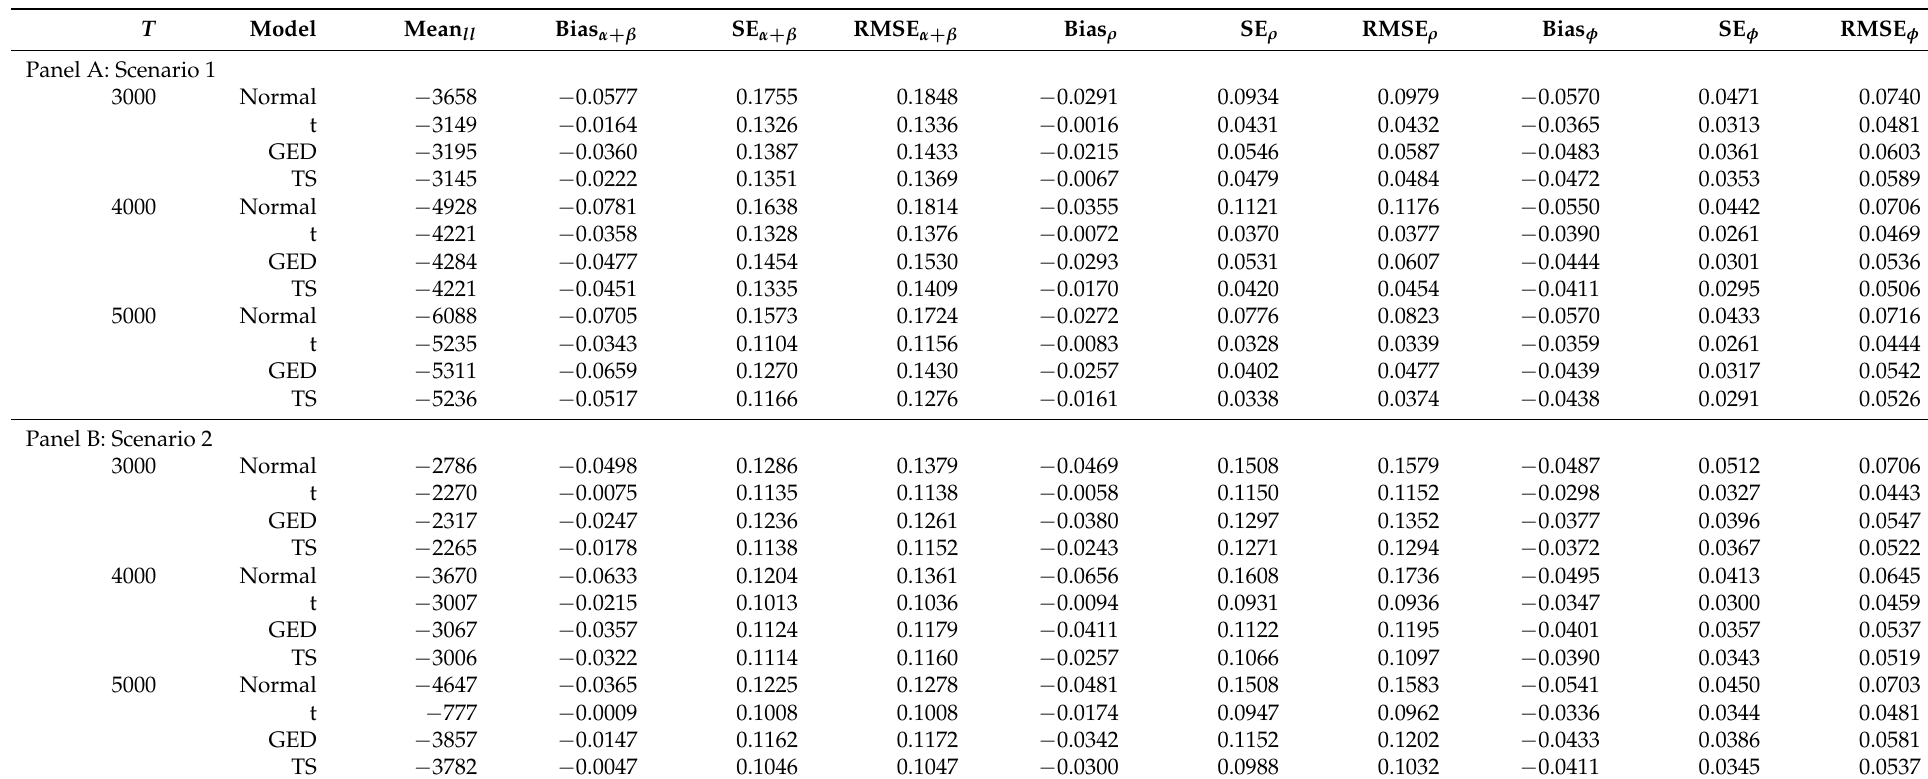
Table 1. Simulation results: Student’s